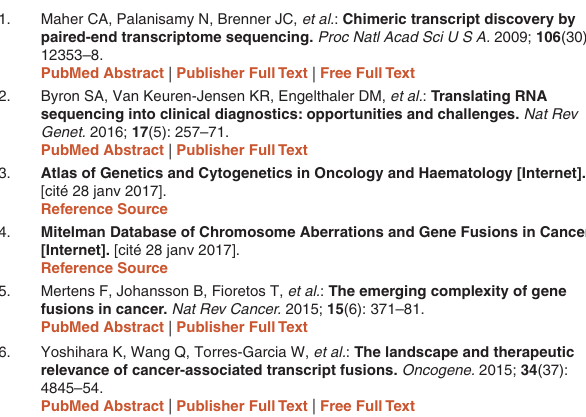
indicated chRNA as described in materials and methods. Only positive samples were retained to calculate the average tag expression. The tag counts are normalized per 5 billion of total k-mers. Click here to access the data. Figure S5: Expression profile of genes involved in Class3 tandem repeat chRNAs. Heat map representing colour-coded expression levels of class3 chimeras (chRNAs normalized count) across patient samples. Names of genes involved in class3 chRNAs are indicated on the right. Black, pink, green and grey bars at the top represent respectively normal CD34, AML-t(8;21), AML-inv16, AML-t(9;11). Click here to access the data. Table S1: Patient data. ID and patient information for the AML cohort. Click here to access the data. Table S2: CRAC & Cractools pipeline output obtained from OS110089, OM100011 and OM110223 RNAseq data analysis. Click here to access the data. Table S3: Primers table for chRNA qPCR validation. Click here to access the data. Table S4: Validated chRNAs information The table gives the list of TAGs used for tag search approach. For the chRNA, exons involved in the chimeric junction and tag sequences used for the tag search approach are indicated. Click here to access the data. Table S5: NONE and PAN3 tags expression within a set of libraries Specific tags for PAN3 and non-chimeric NONE transcript corresponding respectively to Chr13(+) : 28813770-28813799 and Chr2(-) : 43193287-43193316 position on GRCh37/Hg19 genome were designed and counted in FASTQ files of 52 libraries from various tissues. Expression was normalized per 5 billion of total k-mers. Click here to access the data. Table S6: List of LEUCEGENE and ENCODE datasets used in the study Table S6 describes the different parts of the LEUCEGENE cohort used in the study. Samples indicated by a GSM number are classified by groups of different Karyoptype. Table S6 also indicates the ENCODE dataset used in the study. Click here to access the